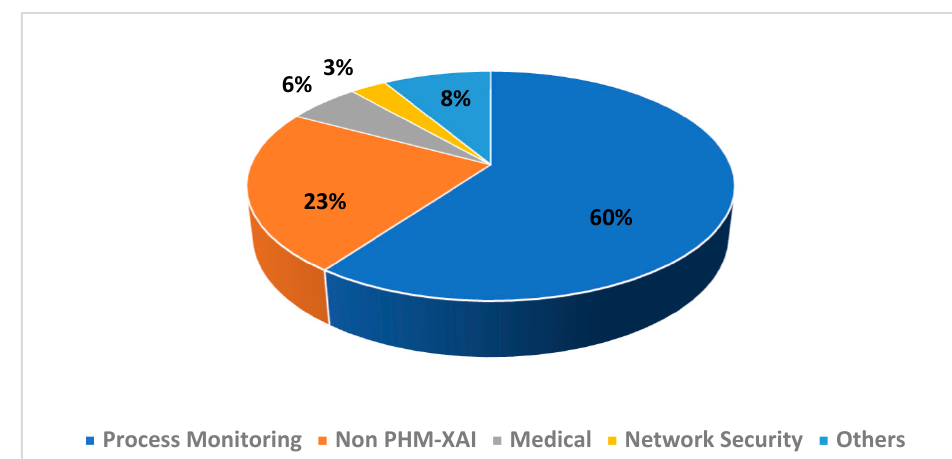
Figure 5. Distribution of the excluded articles according to the topic.